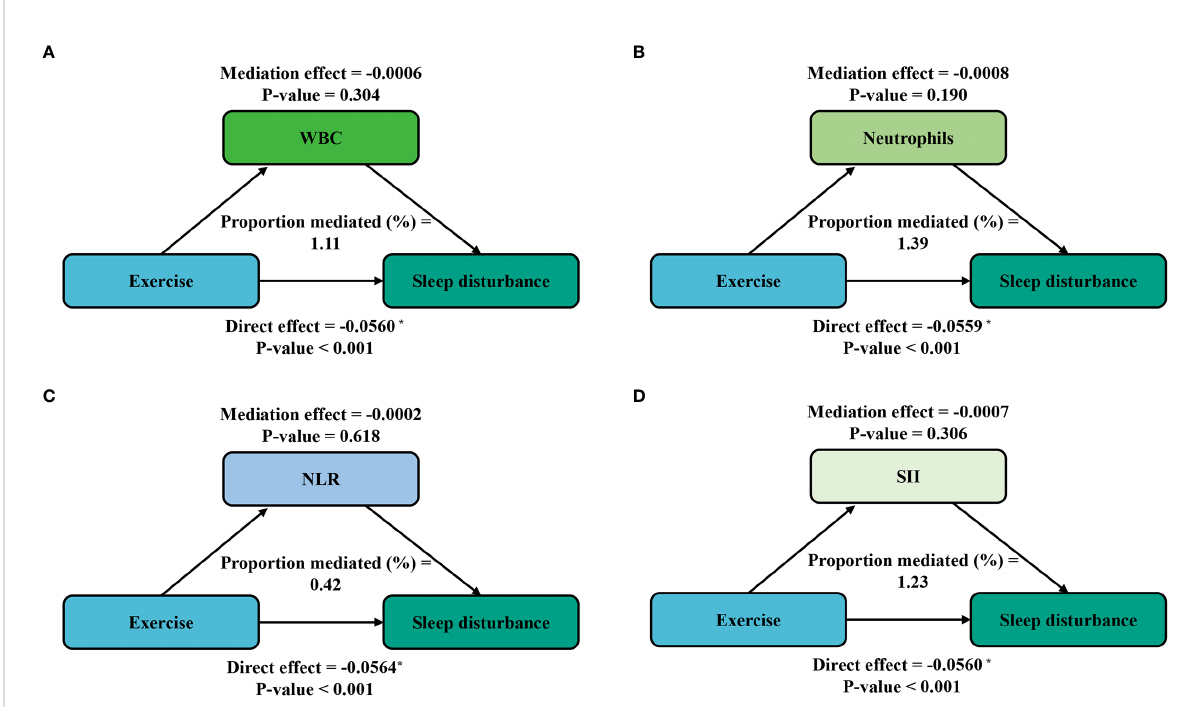
FIGURE 4 Path diagram of the mediation analysis of in fl ammatory biomarkers on the relationship between exercise and sleep disturbance in the severe sedentary groups. The graphs in (A – D) represented the mediating role of WBC, neutrophils, NLR, and SII,